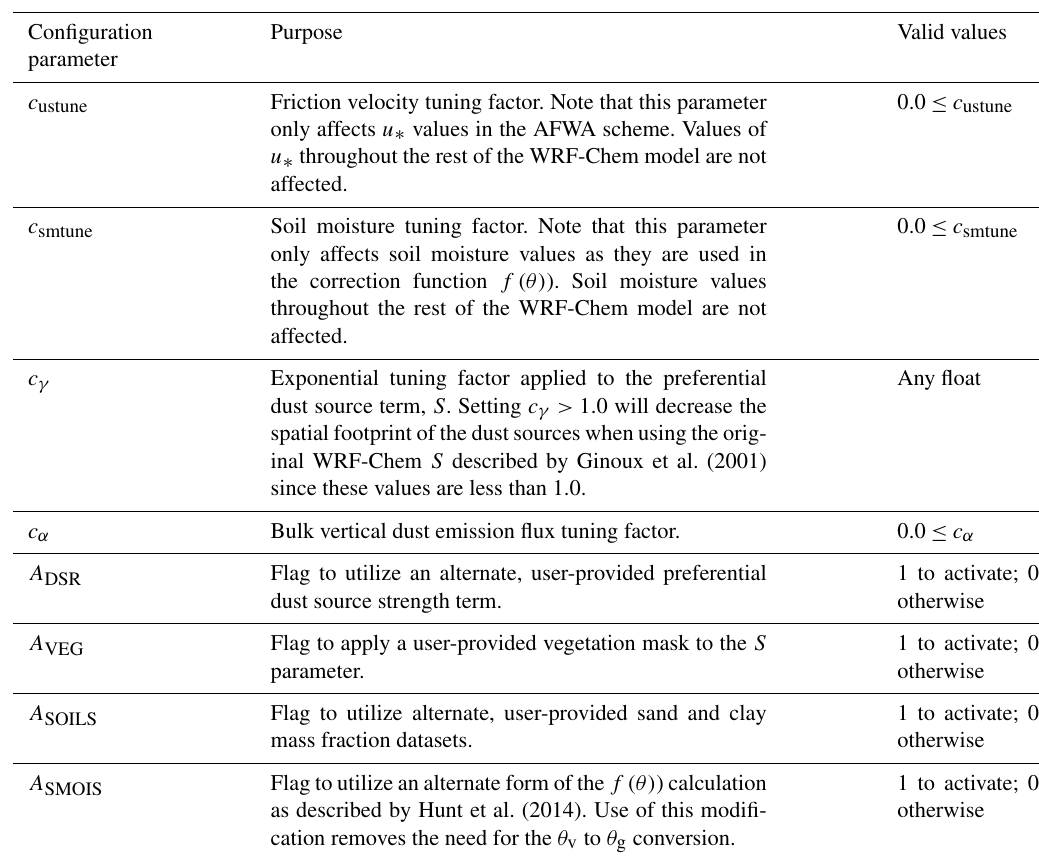
Table 3. Optional tuning parameters and binary configuration flags ( A ).